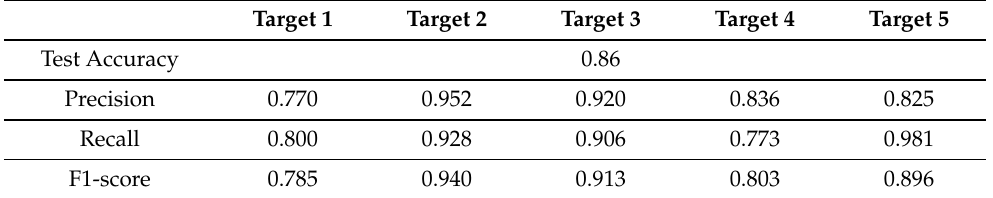
Table 9. The classification performance without data augmentation.